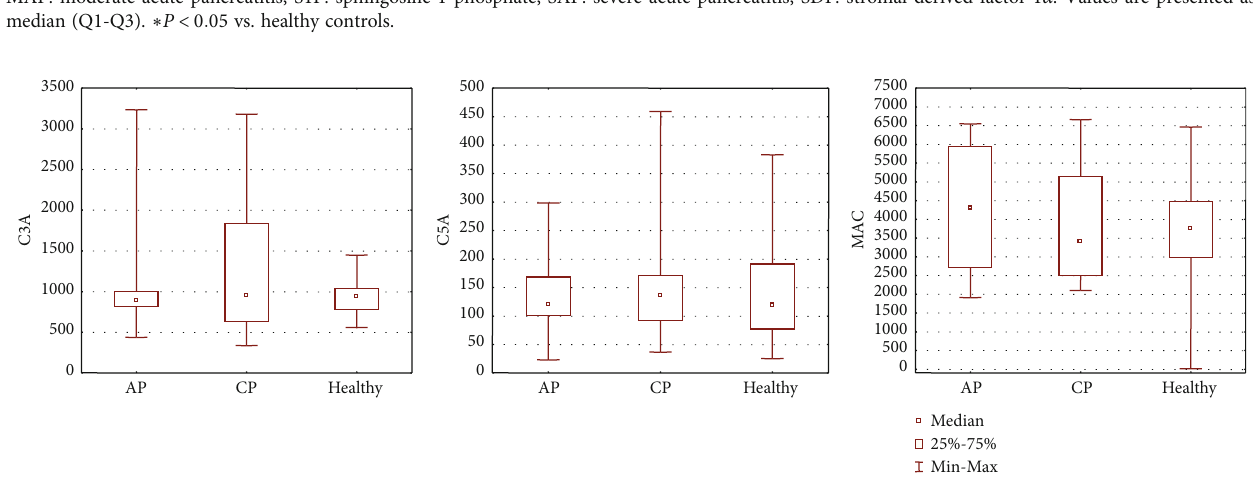
Figure 5: Serum concentrations of complement proteins C3a, C5a, and